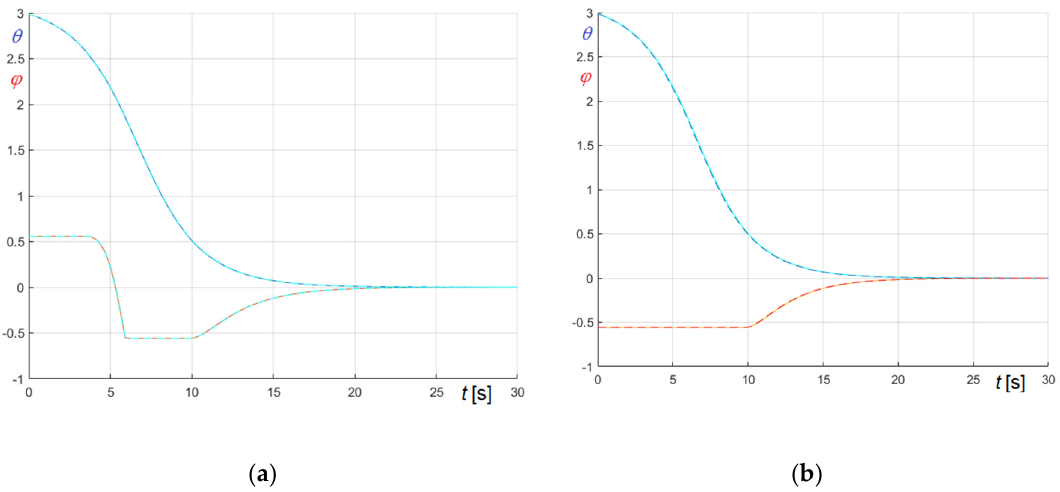
Figure 11. Comparison of t − θ and t − ϕ curves obtained in overdamped conditions ( ζ = 3.44, ζ c = 1.82 ) adopting time steps ∆ t = 10 ms (dashed lines) or ∆ t = 0.025 ms (solid lines): ( a ) Initial conditions given by Equation (64); ( b ) Initial conditions given by Equation (65).